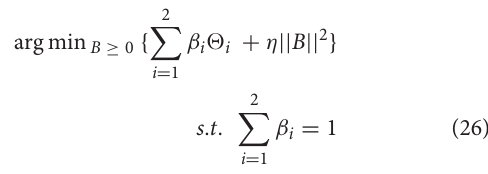
FIGURE 5 | AUC of LOOCV compared with EGBMMDA,ICFMDA, RLSMDA, and